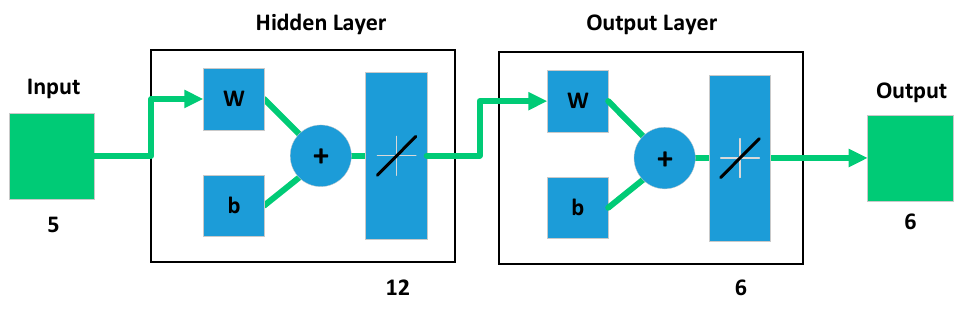
Figure 8. The topological type of the BP neural network.